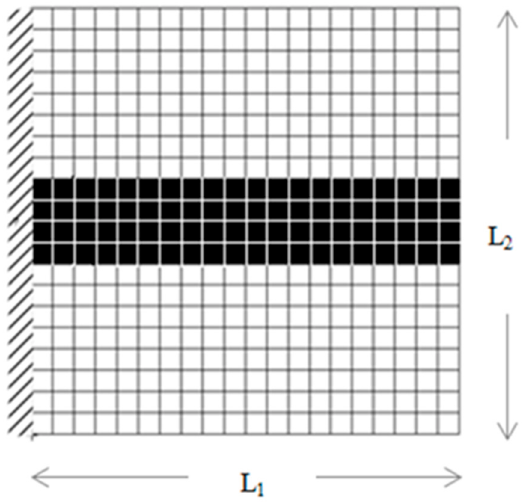
Figure 2. FE model of the plate. Table 1. Material property.